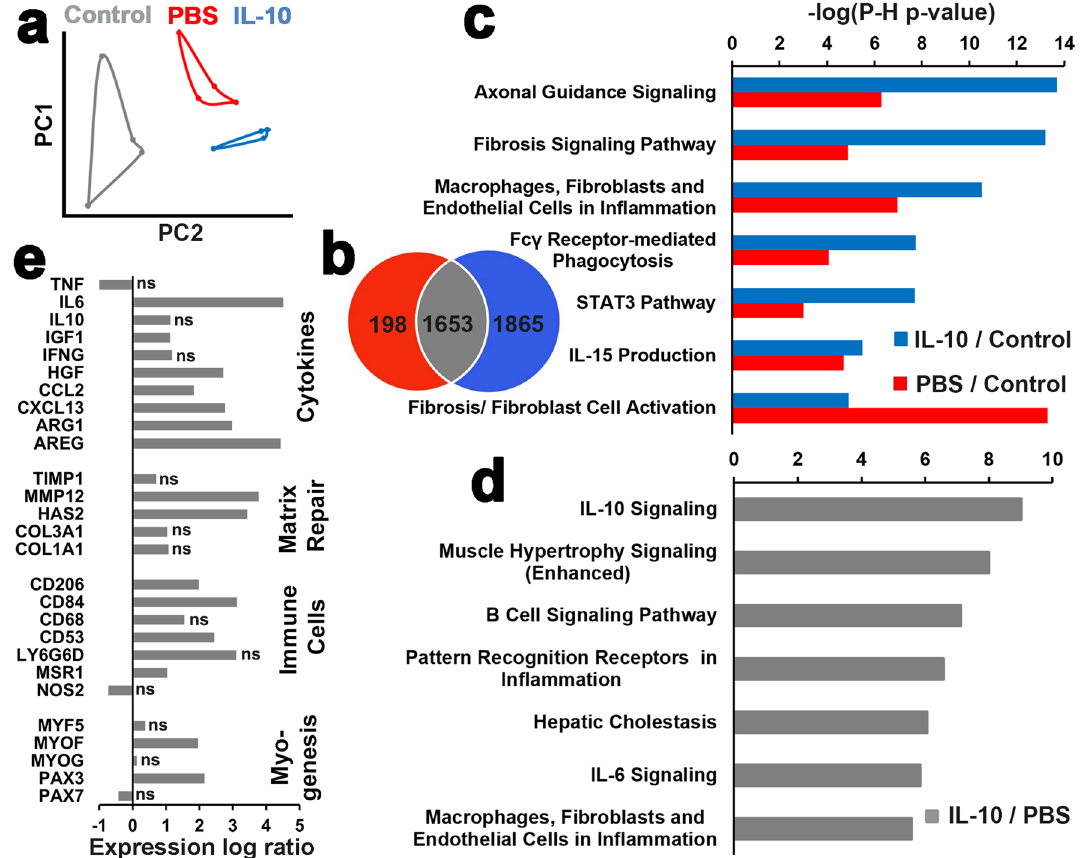
Figure 3. Delayed IL-10 delivery enhanced key muscle wound healing transcripts and signaling pathways. ( a ) PCA of TA skeletal muscle transcriptomes from uninjured, PBS, and IL-10 groups normalized CPM using all transcripts. ( b ) Venn diagram illustrates differentially expressed gene counts for IL-10 treatment and PBS controls groups with respect to uninjured controls. ( c ) Top canonical pathways based on the Ingenuity Pathway Analysis (IPA) assessment of differentially expressed genes (FDR < 0.05 and |log 2 FC|> 1.5) within IL-10 treatment and PBS controls with respect to uninjured controls. ( d ) Selected gene expression for key IL-10 treatment group genes with respect to PBS controls are presented as log ratio (log 2 FC). ( e ) Top canonical pathways based on IPA assessment of differentially expressed genes of IL-10 with respect to PBS. “ns” indicates no significant difference (FDR >